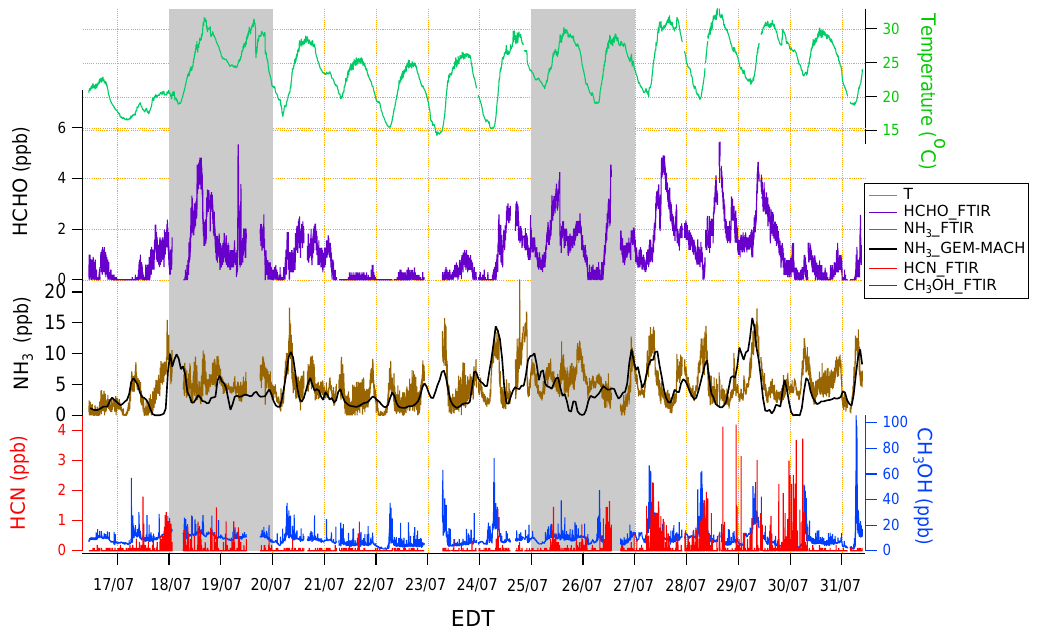
Figure 6. Time series of ambient temperature, mixing ratio of HCHO, NH 3 , HCN, and CH 3 OH for the 16-day study period. Grey shaded areas indicate the weekend